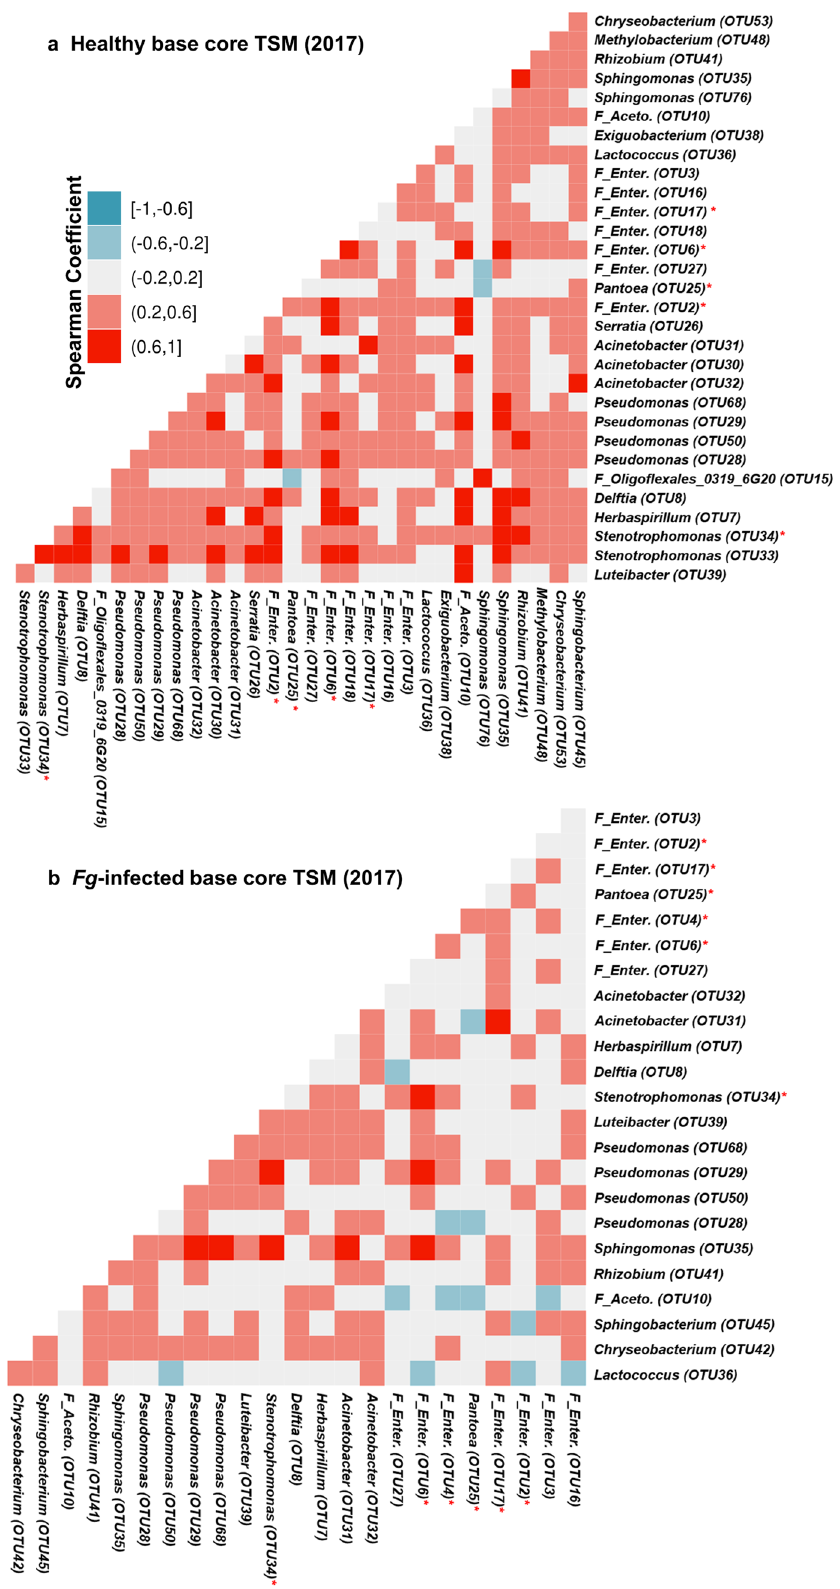
Figure 5. Co-occurrence of core TSM in healthy and Fg -infected states. ( a , b ) Co-occurrence of core taxa displaying calculated Spearman’s rank correlation coefficients in 2017 for ( a ) healthy base tissues and ( b ) Fg - infected base tissues (also see Supplementary Fig. S13a–f).Taxa tagged by a red asterisk denote Fg -indicators in silk base,